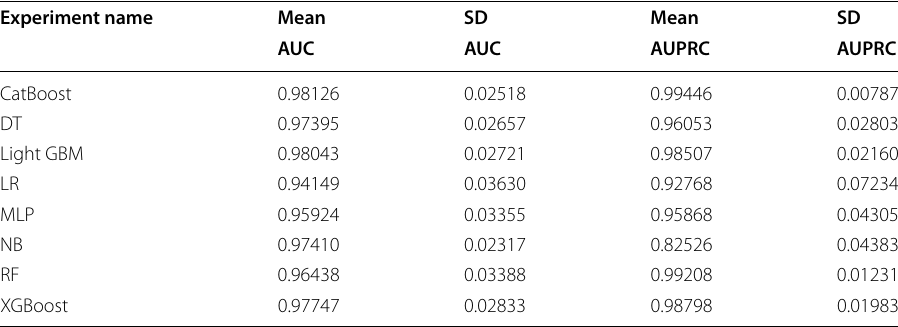
Table 17 Classification results for the data exfiltration dataset no sampling default hyperparameter values experiments; mean and standard deviations of AUC and AUPRC, (10 iterations of 5-fold